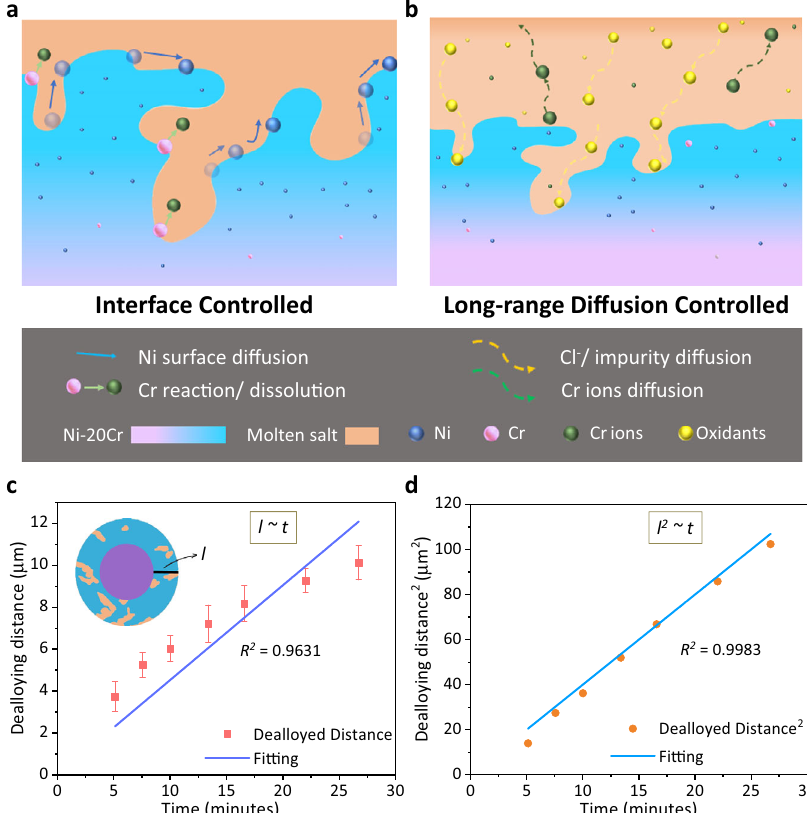
Fig. 4 Dealloying mechanism in molten salt. a and b Four steps involved in molten salt dealloying of Cr from Ni – 20Cr. a Interface-controlled processes: Ni surface diffusion, Cr reaction/dissolution, b Long-range diffusion-controlled processes: oxidants diffusion and Cr ion diffusion through the tortuous porous structure. c and d The power-law fi tting l n ~ t of the dealloying distance ( l n , n = 1, 2) vs. time ( t ) with the goodness of fi t. The schematic inset in c showed the circle fi tting method to determine l using the virtual XY plane images from the in situ X-ray nano-tomography experiment. The error bars in c are de fi ned as the standard deviation in calculating l from different pseudo cross-sections. Note that the error bars in d are included but they are not visible due to the scale (for the complete data, see Supplementary Table